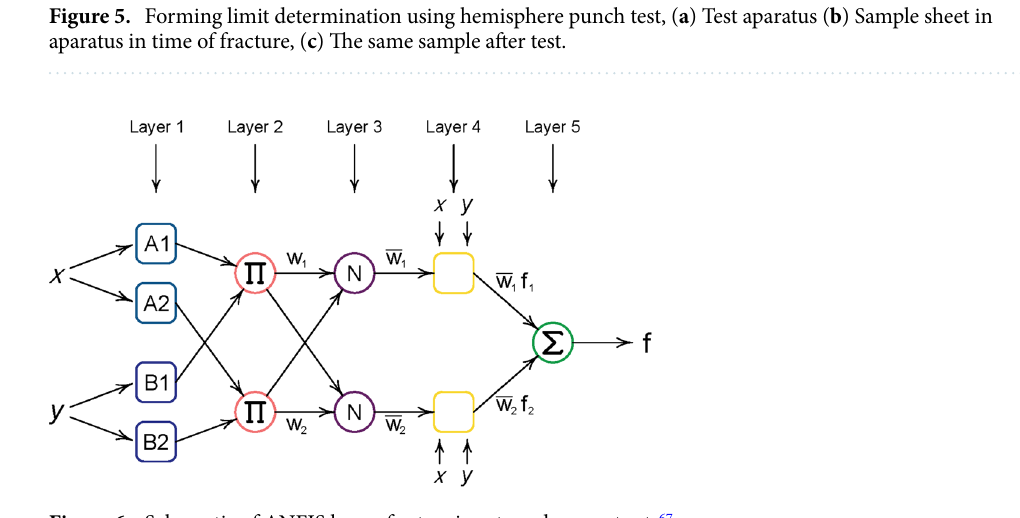
Figure 6. Schematic of ANFIS layers for two inputs and one outputs 67